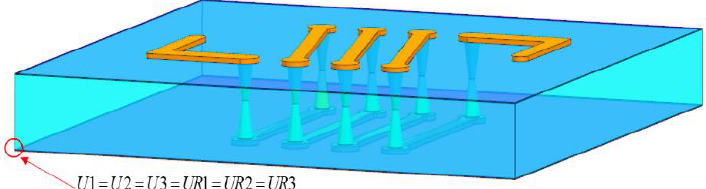
Figure 5. The 3D TGV structure model.